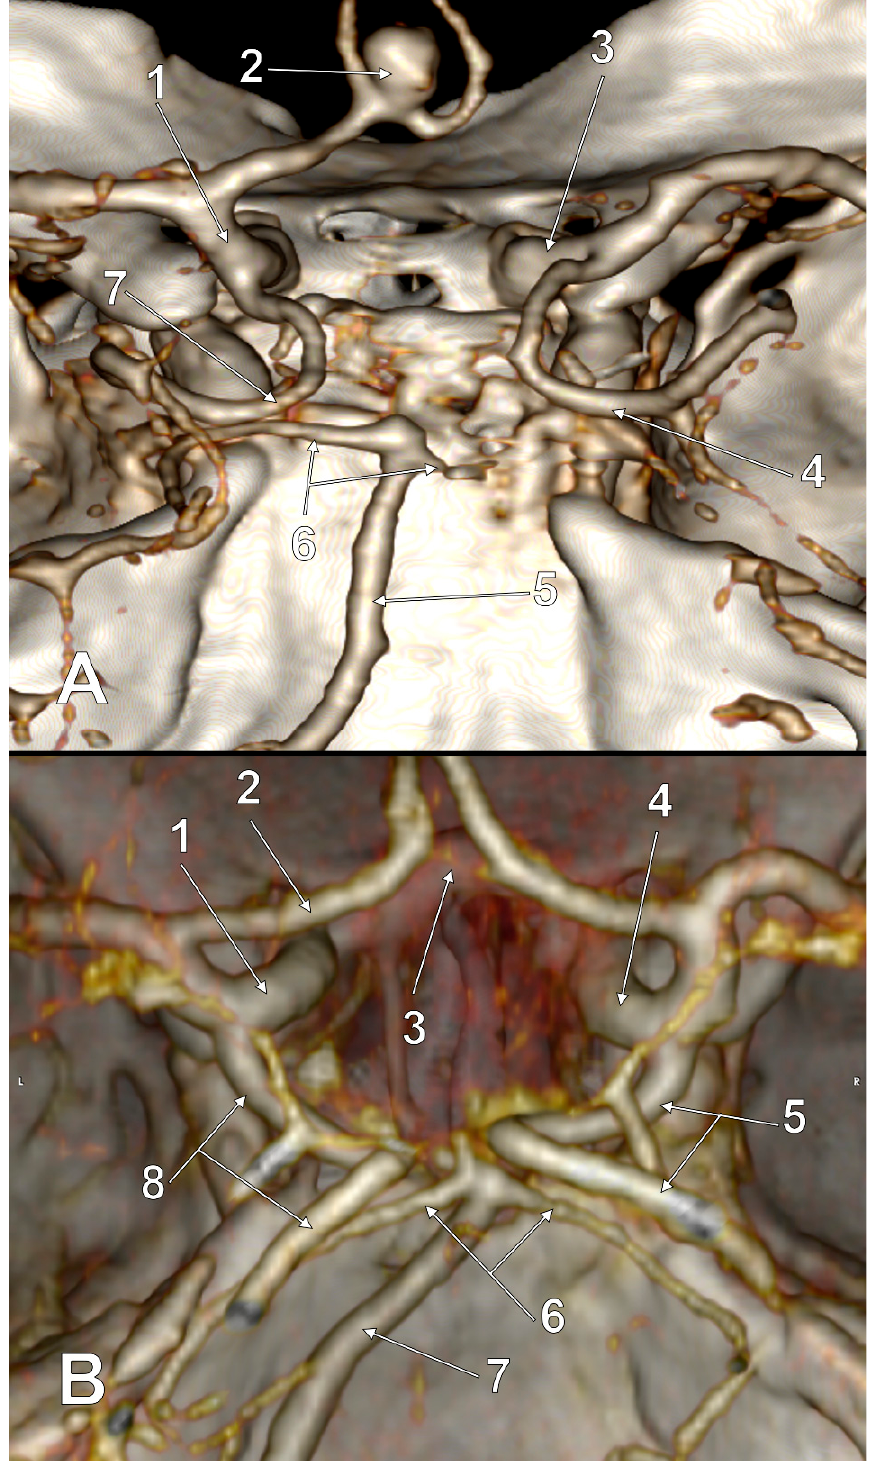
Figure 5. Postero-superior views of the cW. Bilateral full/complete FPCAs (f-FPCA+f-FPCA). Three variant sides of the cW. ( A ) Aplastic right A1 and bilateral aplasia of P1. 1. Left ICA; 2. AcomA aneurysm; 3. Right ICA (isolated ICA); 4. Right f-FPCA; 5. BA; 6. Superior cerebellar arteries; 7. Left f-FPCA. ( B ) Hypoplastic AComA and bilateral aplasia of P1. 1. Left ICA; 2. A1 segment of the left ACA; 3. Hypoplastic AComA; 4. Right ICA; 5. Right f-FPCA; 6. Superior cerebellar arteries; 7. BA; 8. Left f-FPCA.